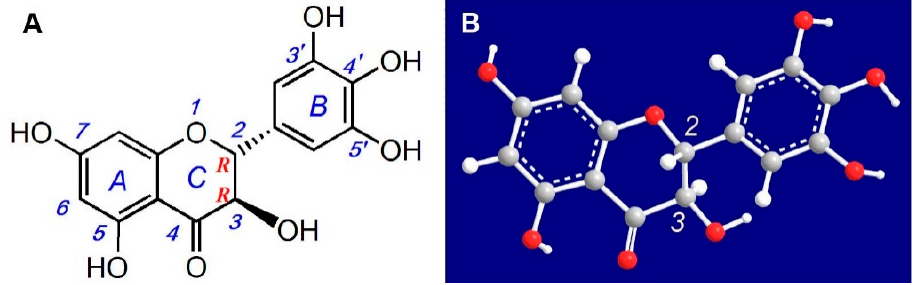
Figure 1. The chemical structure ( A ) and ball-stick model ( B ) of dihydromyricetin (DHM, 2R , 3R -3,5,7,3’,4’,5’-hexahydroxy-2,3-dihydroflavonol).